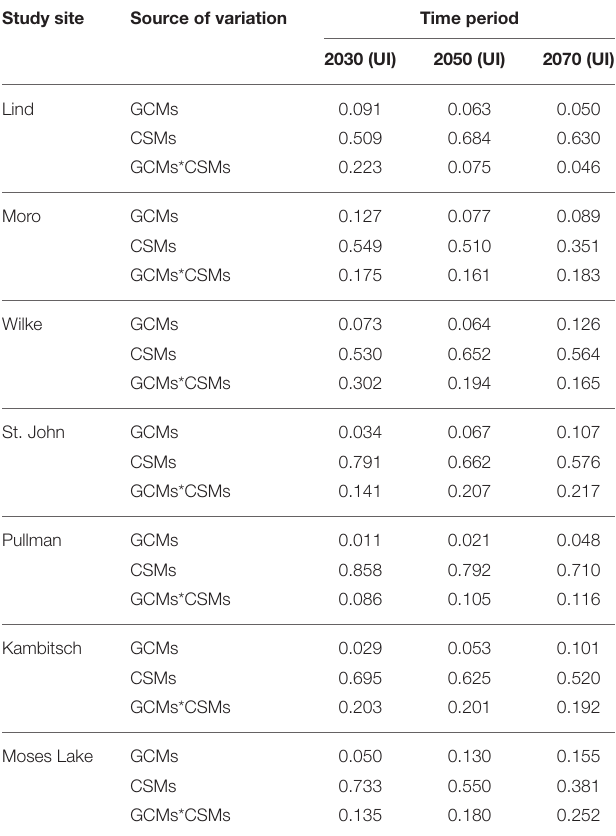
TABLE 7 | Uncertainty Index (UI) for projected winter wheat yield at seven sites in the Pacific Northwest modeled under 14 general circulation models (GCMs) averaged over 2 representative concentrations pathways in each of 5 cropping system models